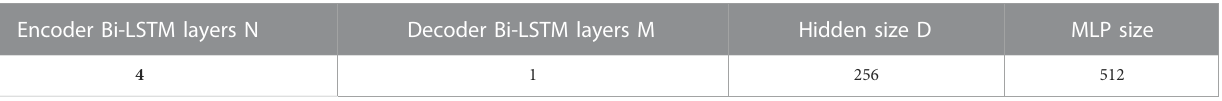
TABLE 2 Details of the pre-training